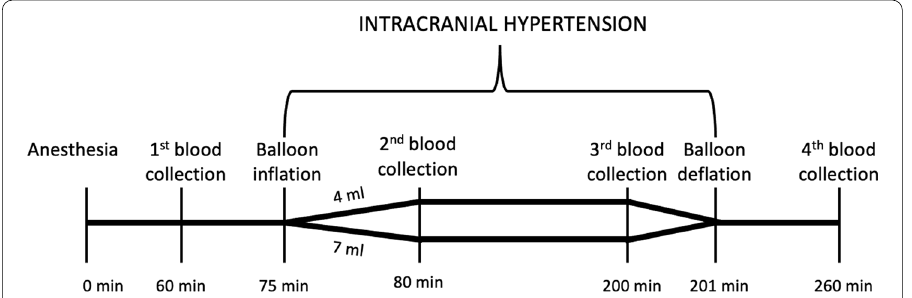
Fig. 1 Study design. Blood for cytokines analysis was collected before (1st), during (2nd/3rd) and after (4th) simulating intracranial